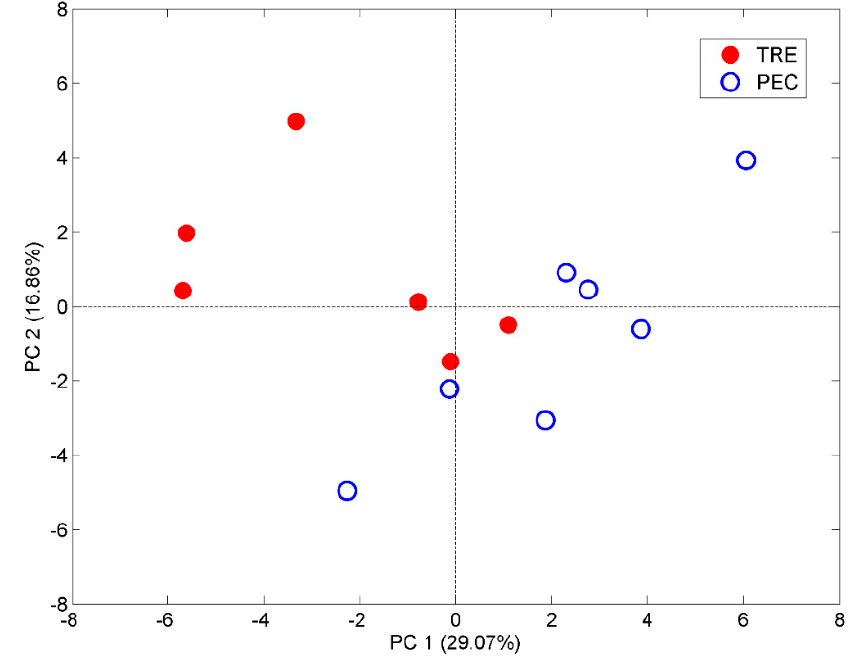
Figure 8. Projection of PEC and TRE wine samples onto the plane of the first two principal components (PC1 and PC2) extracted from the volatile profiles collected with the DVB/CAR/PDMS fiber.